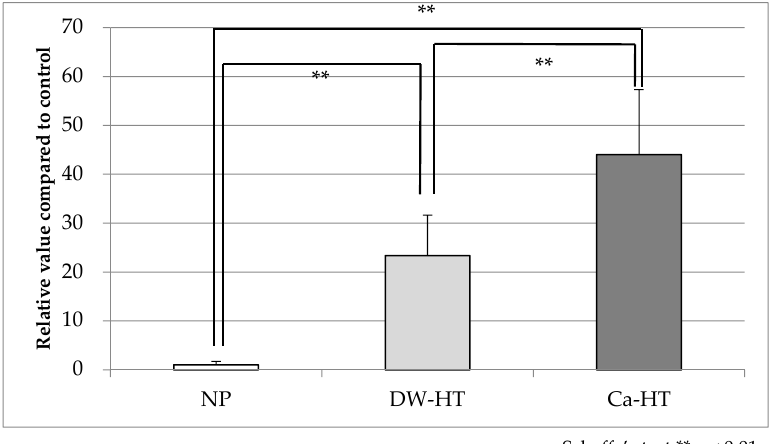
Figure 1. Recombinant human laminin-332 (rhLN) adsorption. There were statistically significant differences among the groups ( p < 0.01). NP, non-process; DW-HT, hydrothermal treatment with water; Ca-HT, hydrothermal treatment with calcium chloride solution.